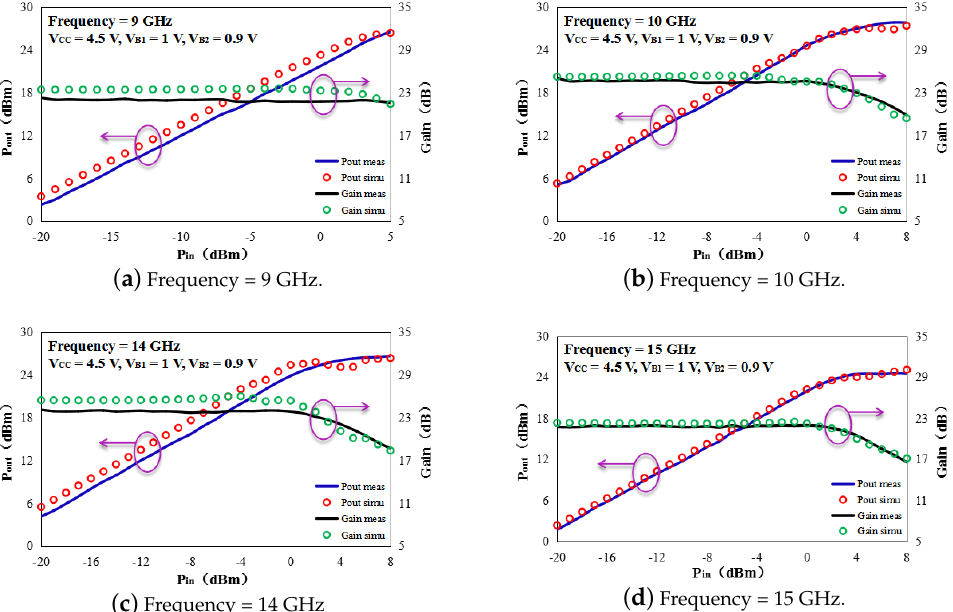
Figure 16. Comparison results of the GaAs E-mode pHEMT PA